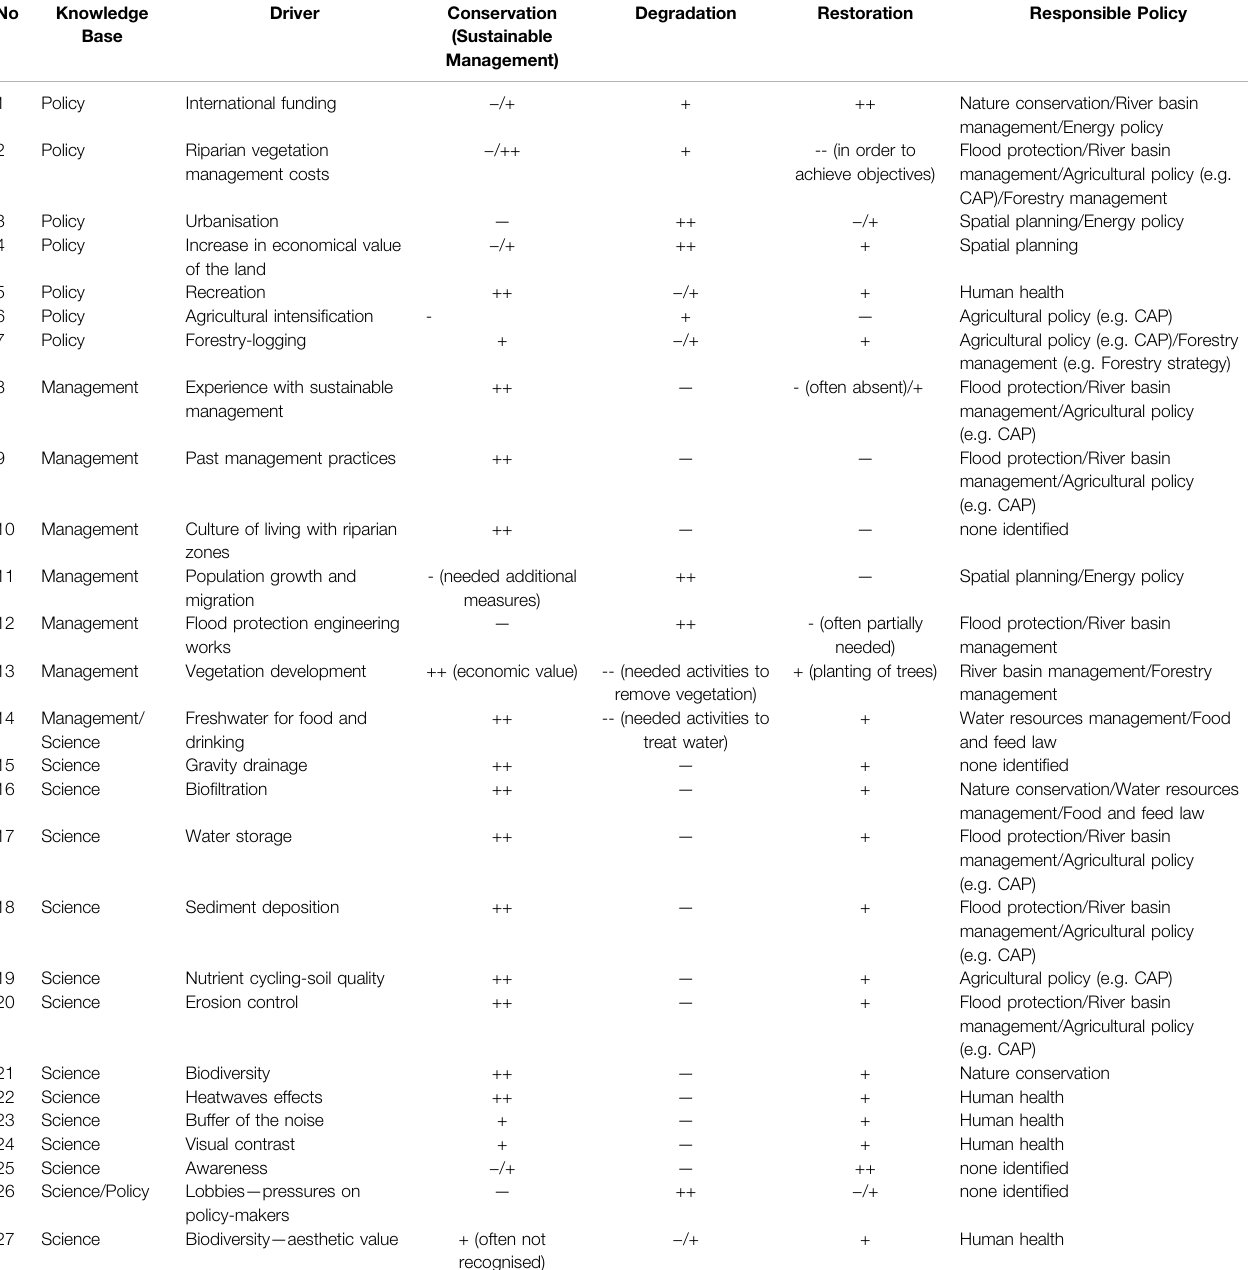
TABLE 1| Riparianzonemanagementdriversinrelationtoknowledgeandresponsiblepolicy.Thebelowsymbolsindicatethespectrumofdegreeanddirectionality(++,+,-,--)forhow each identi fi ed driver contributes to three concepts of riparian zone management: conservation, degradation, and restoration (e.g. international funding, there is a range of modest positiveandnegativeincentivesforconservation,positiveincentivesfordegradation,andverypositiveincentivesforrestoration).Driversbelongtothreedifferentknowledgebases:policy, managementandscience.Keyinterpretationsincludethat, fi rst,especiallypolicydriversmightshowaspectrumofcontributionlevels.Second,managingresponsibilitiesofdriverswitha spectrum of contribution levels are usually scattered across different authorities, which is a clear indication that policy co-creation is needed. Third, several natural sciences and managementrelateddriverswithadirectimpactonhumanwell-beingarelistedinpositivecontributiontoconservation.Policyrelateddrivers,however,oftendonotcontributeenough to conservation and thus sustainable human